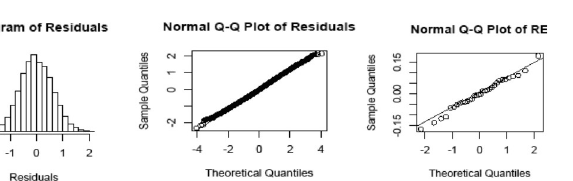
Fig 3. Residuals. Left: Histogram of the residuals. Middle: qq-plot of the residuals. Right: qq-plot of the residuals of the random effects.